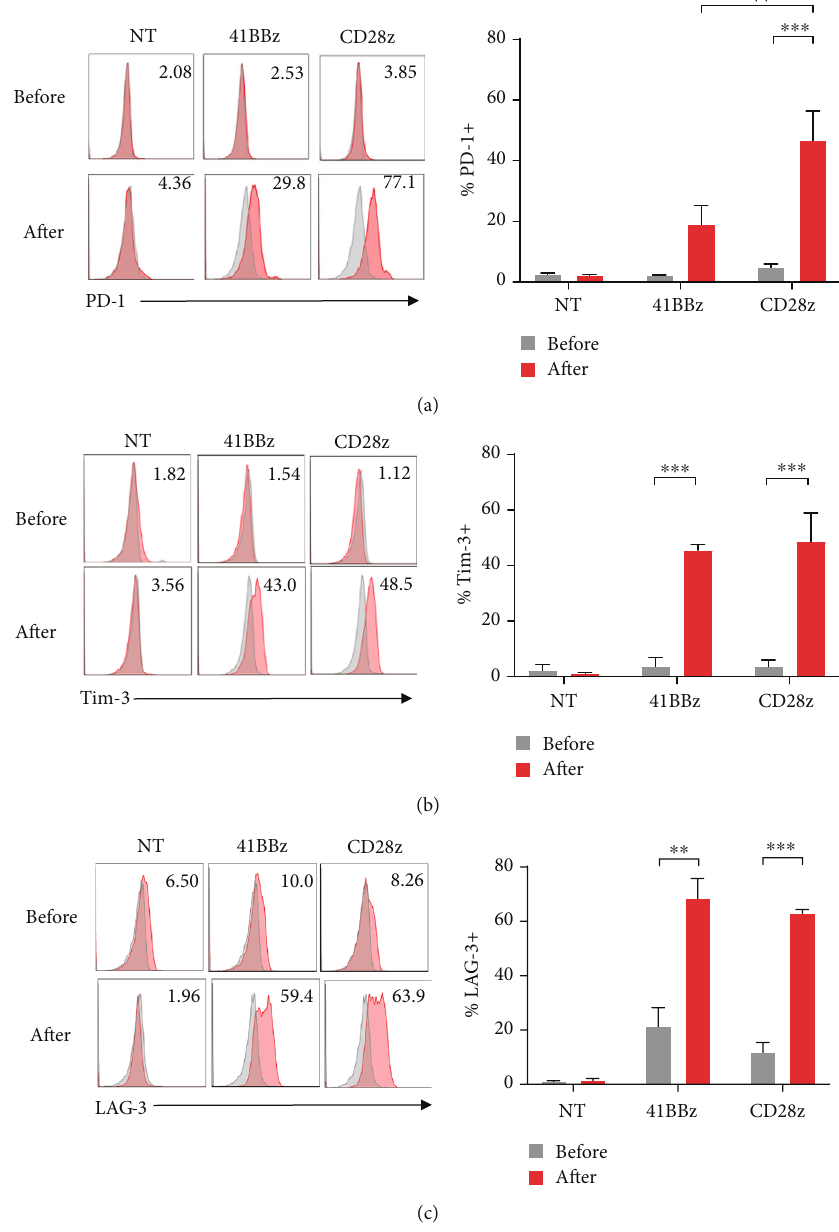
Figure 5: CAR.MUC1-41BB ζ exhibits less PD1 upregulation after antigen stimulation. (a – c) Representative histogram (left) and mean percentage (right) demonstrating the surface expression of PD-1 (a), TIM-3 (b), and LAG-3 (c) on nontransduced, CAR.MUC1-41BB ζ and CAR.MUC1-CD28 ζ T cells before and after coculture with MUC1 + breast cancer cell line, and MCF-7 at ratio 1:1 for 72h. Data represents as mean ± S : E : M ( n = 6 ). Statistical signi fi cance was determined by two-way ANOVA and indicated as ∗ for P < 0 : 05 , ∗∗ for P < 0 : 01 , and ∗∗∗ for P < 0 : 001